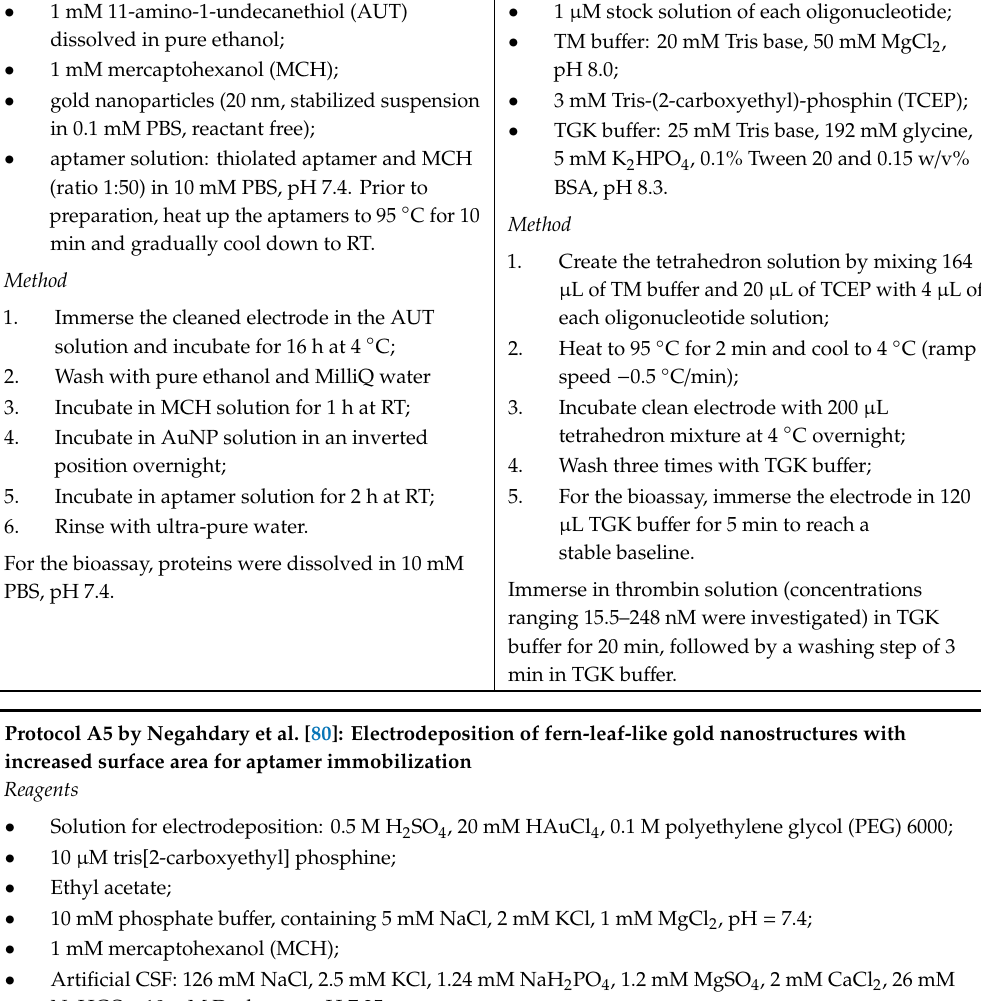
tetrahedron as anchor for aptamer immobilization